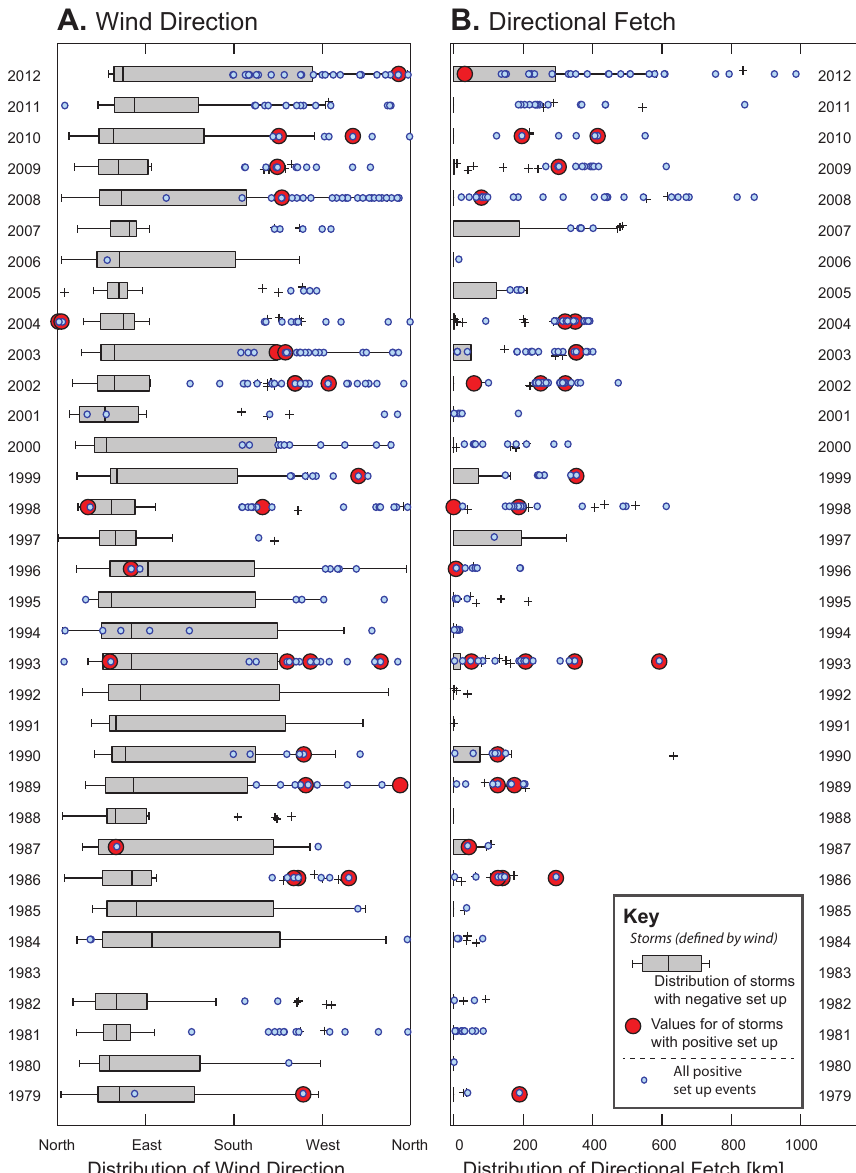
Figure 15. Wind direction (a) and directional fetch (b) by year for all storms (defined as wind ≥ 10ms − 1 ) and for positive setup events. Storms that set up water and positive setup events have winds from the west and north. Directional fetch during storms that set down water and positive setup events have increased through time, while directional fetch during storms that set up water does not exhibit this trend.